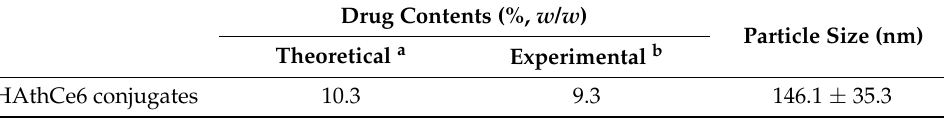
Table 1. Characterization of HAthCe6 conjugates.